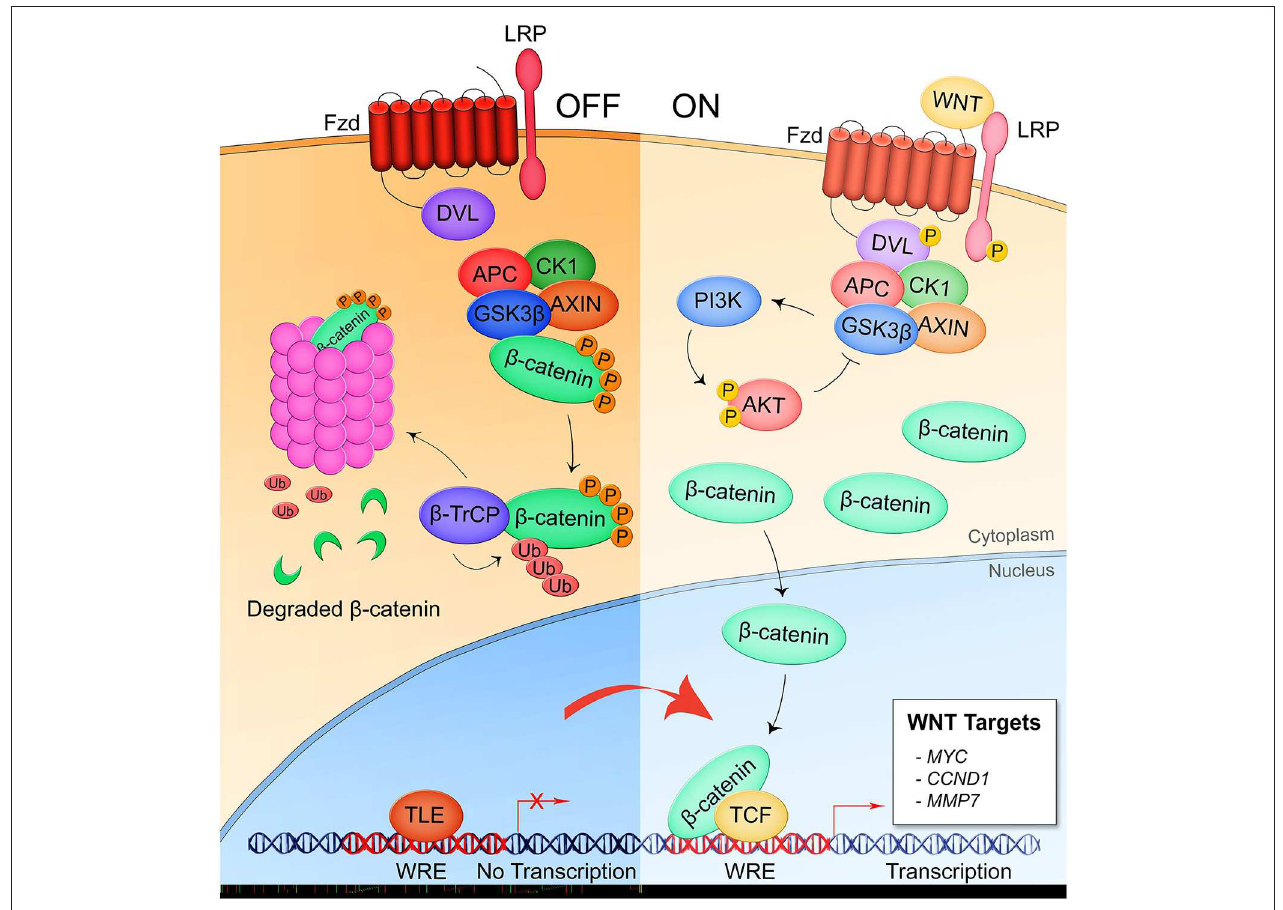
FIGURE 1 | Canonical/ β -catenin-dependent Wnt signaling. In the pathway off state, the β -catenin destruction complex consisting of APC, CK1, GSK3 β , and AXIN binds β -catenin leading to its phosphorylation by GSK3 β and subsequent ubiquitination by the E3 ubiquitin ligase complex β -TrCP which targets β -catenin for proteasomal degradation. Thus, the Wnt response element (WRE) located in the promoter region of Wnt pathway target genes remains bound by transcriptional repressor TLE. When a secreted Wnt ligand originating from the same or a nearby cell binds Fzd and the coreceptor LRP5/6, Dvl is phosphorylated and sequesters the destruction complex, preventing the phosphorylation of β -catenin. Accumulation of β -catenin is the cytoplasm leads to nuclear translocation of the protein where it binds with co-activator TCF at the WRE and drives expression of Wnt target